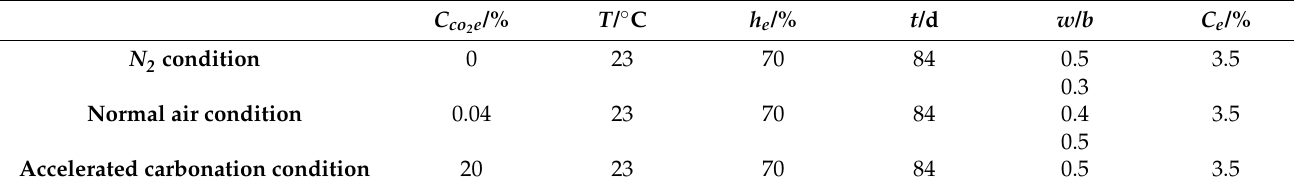
Table 3. Values of some key parameters employed in the modeling.